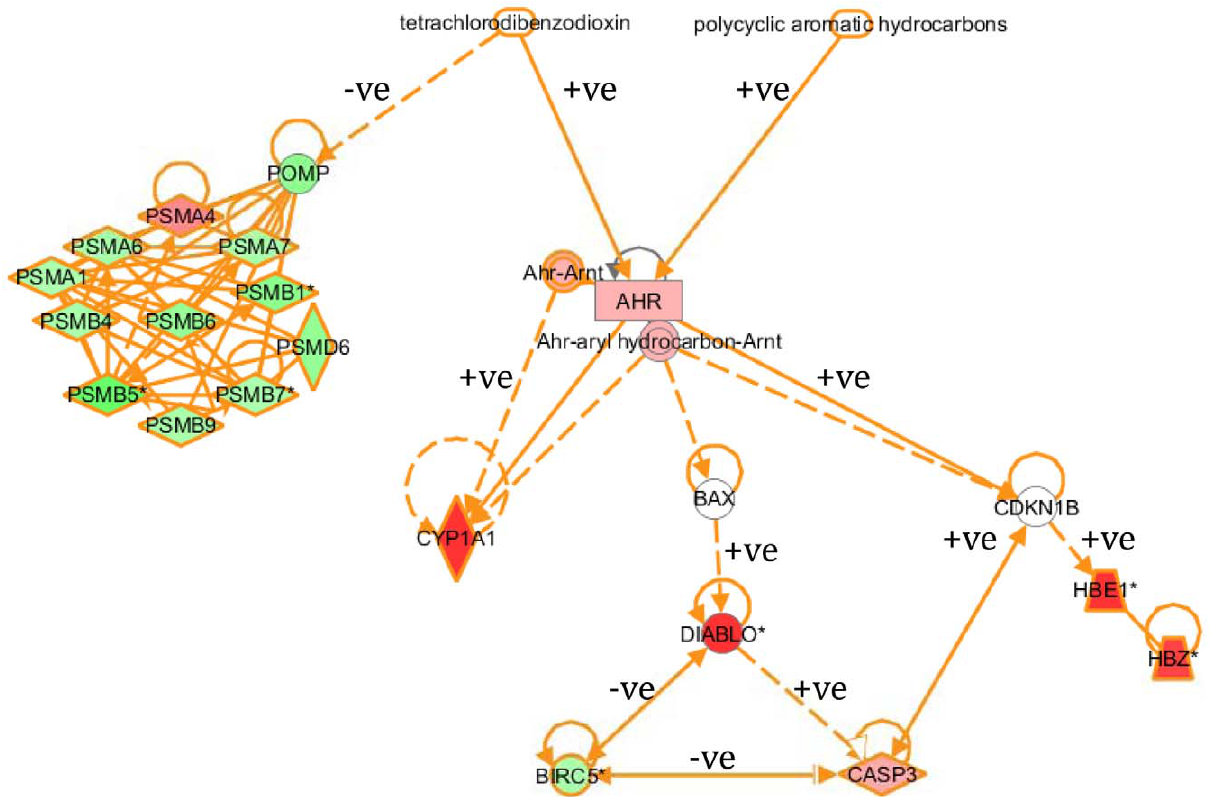
Figure 7. Relationship between the AhR pathway and proteasome. Relationship between the AhR pathway and proteasome, generated within Ingenuity, coloured deep red or green for changes exceeding 2-fold up and down respectively between Brunsbuttel and Alde fish, and light red and green for those less than 2-fold.